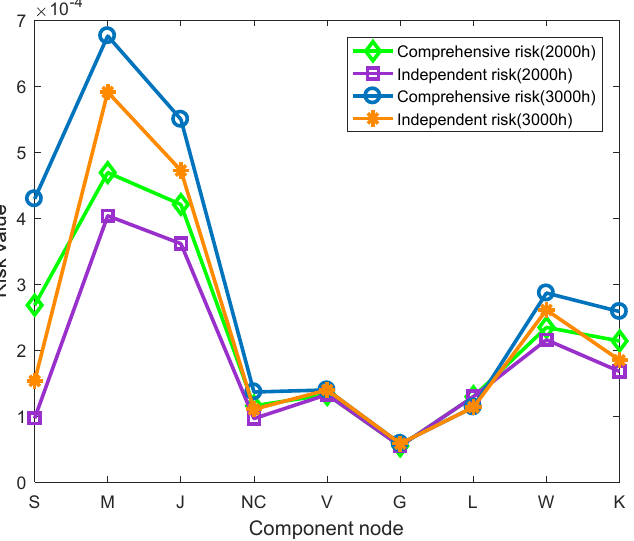
Figure 13. Comparison diagram of the ranking trend of component risk values at different moments.